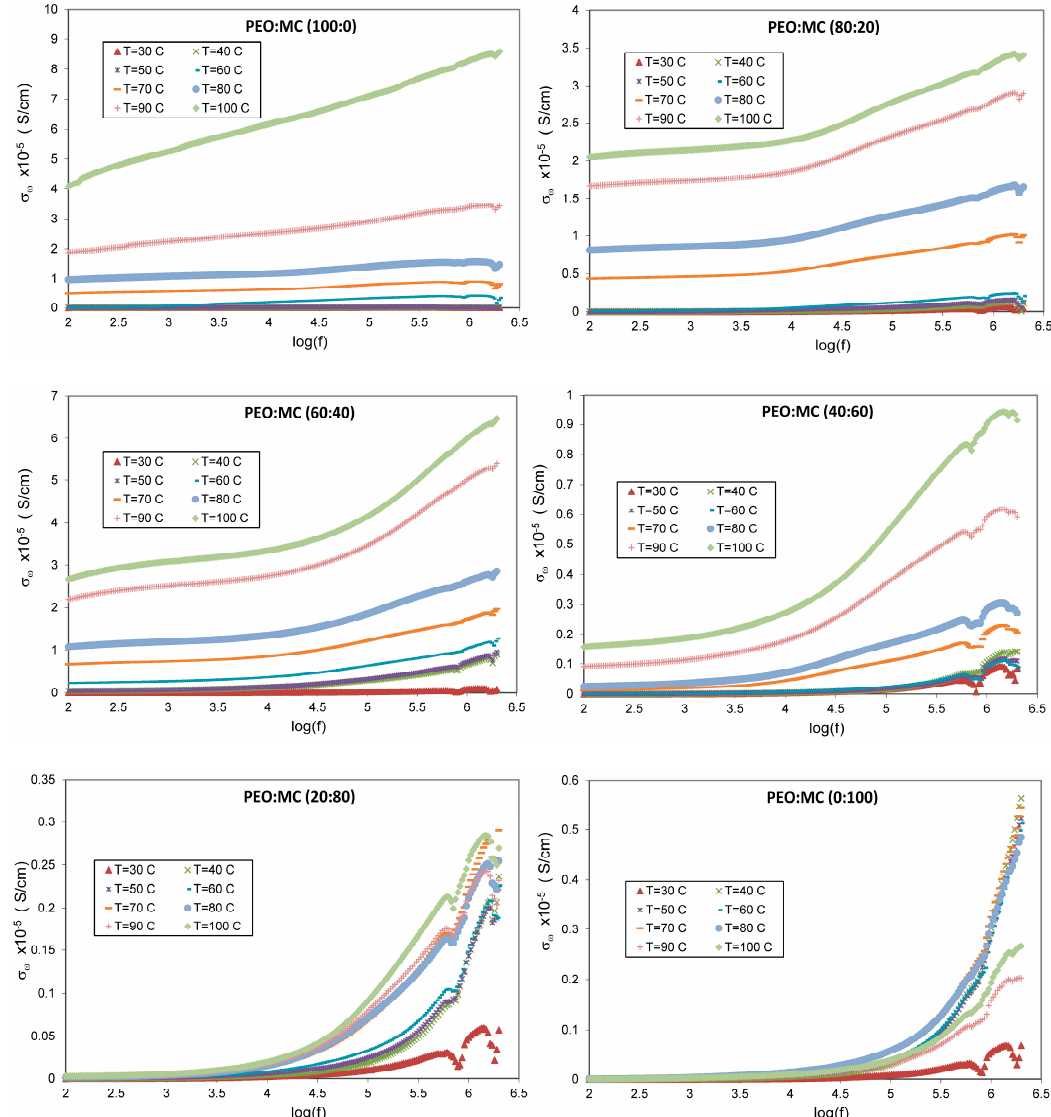
Figure 8. The total conductivity spectra for different compositions of PEO:MC in the temperature range